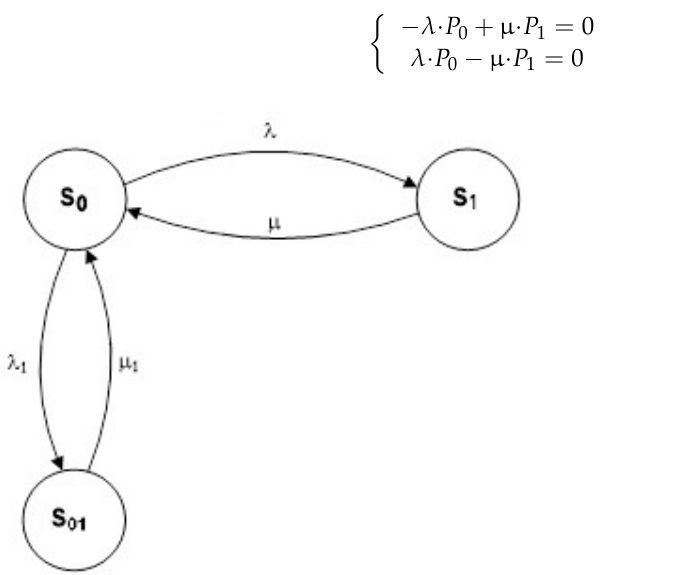
Figure 2. Diagram of the process of operating wind farm equipment with intelligent WPPES systems and an artificial neural network decision support concerning safety in its use (model A).